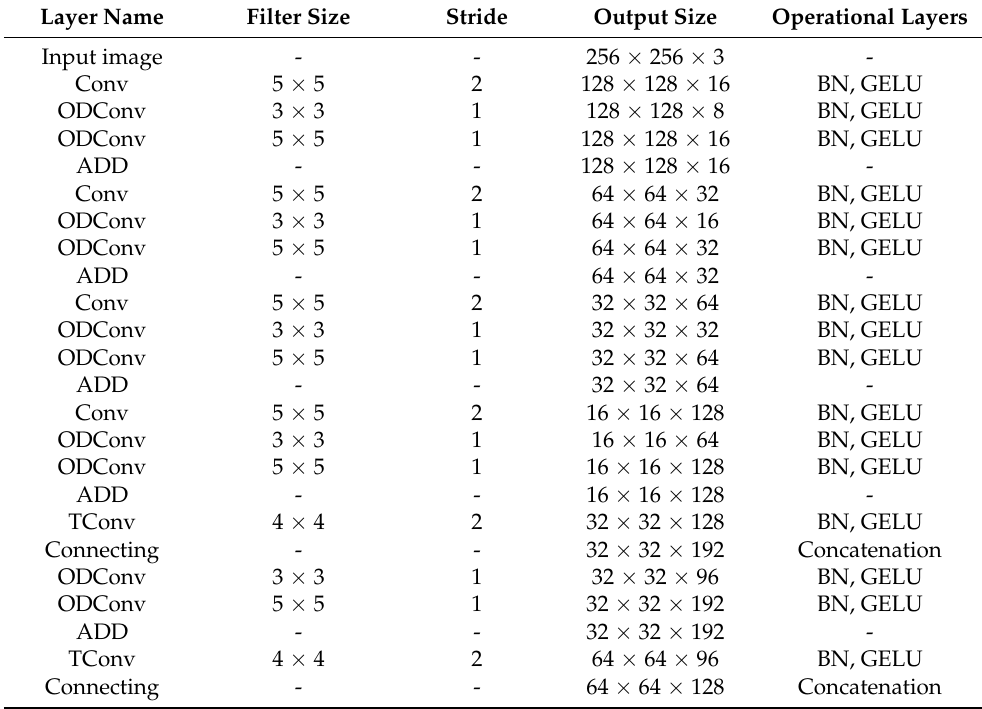
Figure 4. Schematic illustration of CCSN network architecture. Table 1. Detailed parameters in CCSN.